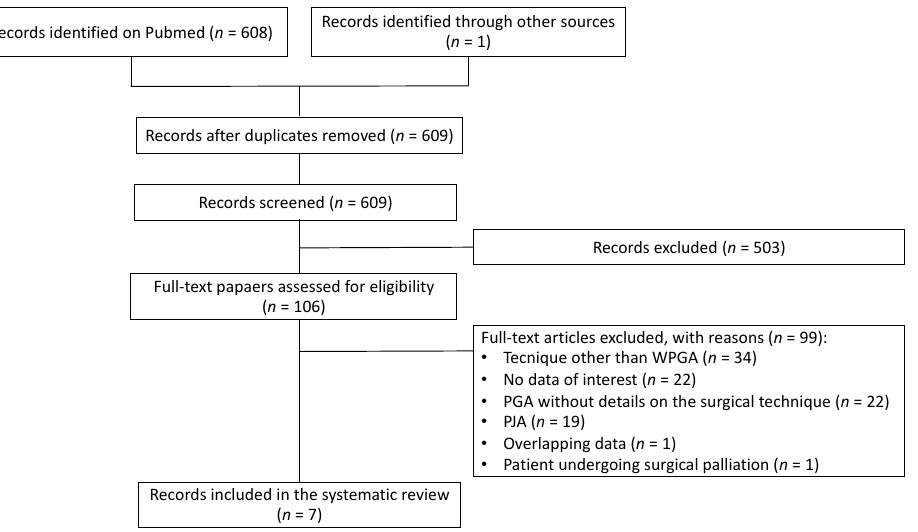
Figure 2. Flowchart of the systematic review. WPGA Wirsung-Pancreato-Gastro-Anastomosis; PGA Pancreatogastric Anastomosis; PJA Pancreatico-Jejunal Anastomosis